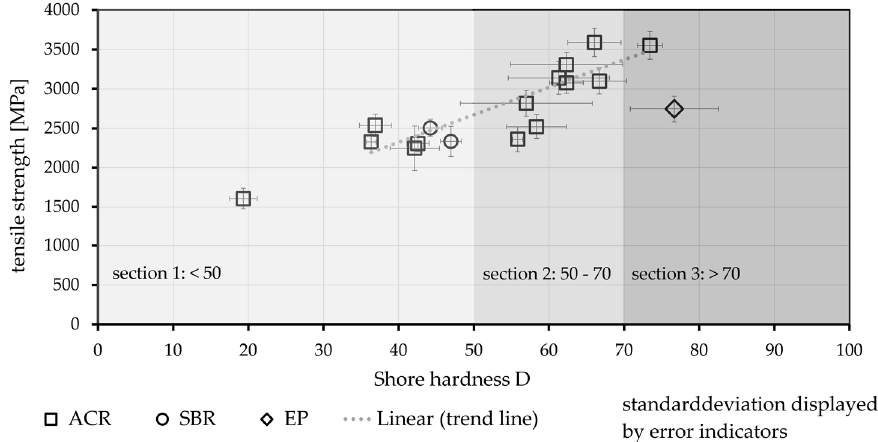
Figure 18. Categorization of the impregnation agents by hardness, <50 = soft, 50–70 = medium stiff, >70 = stiff.